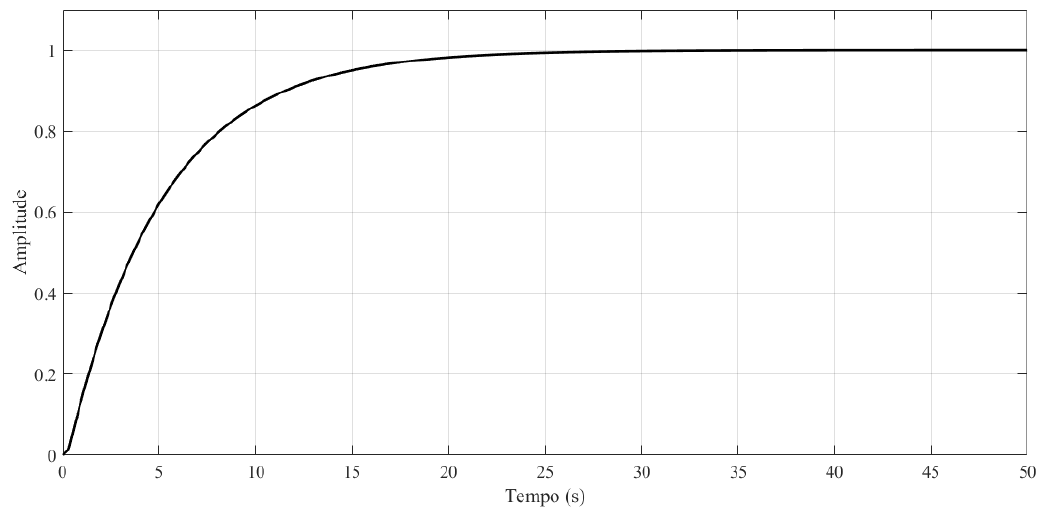
Figure 6. Response to the unit step of the reference model.